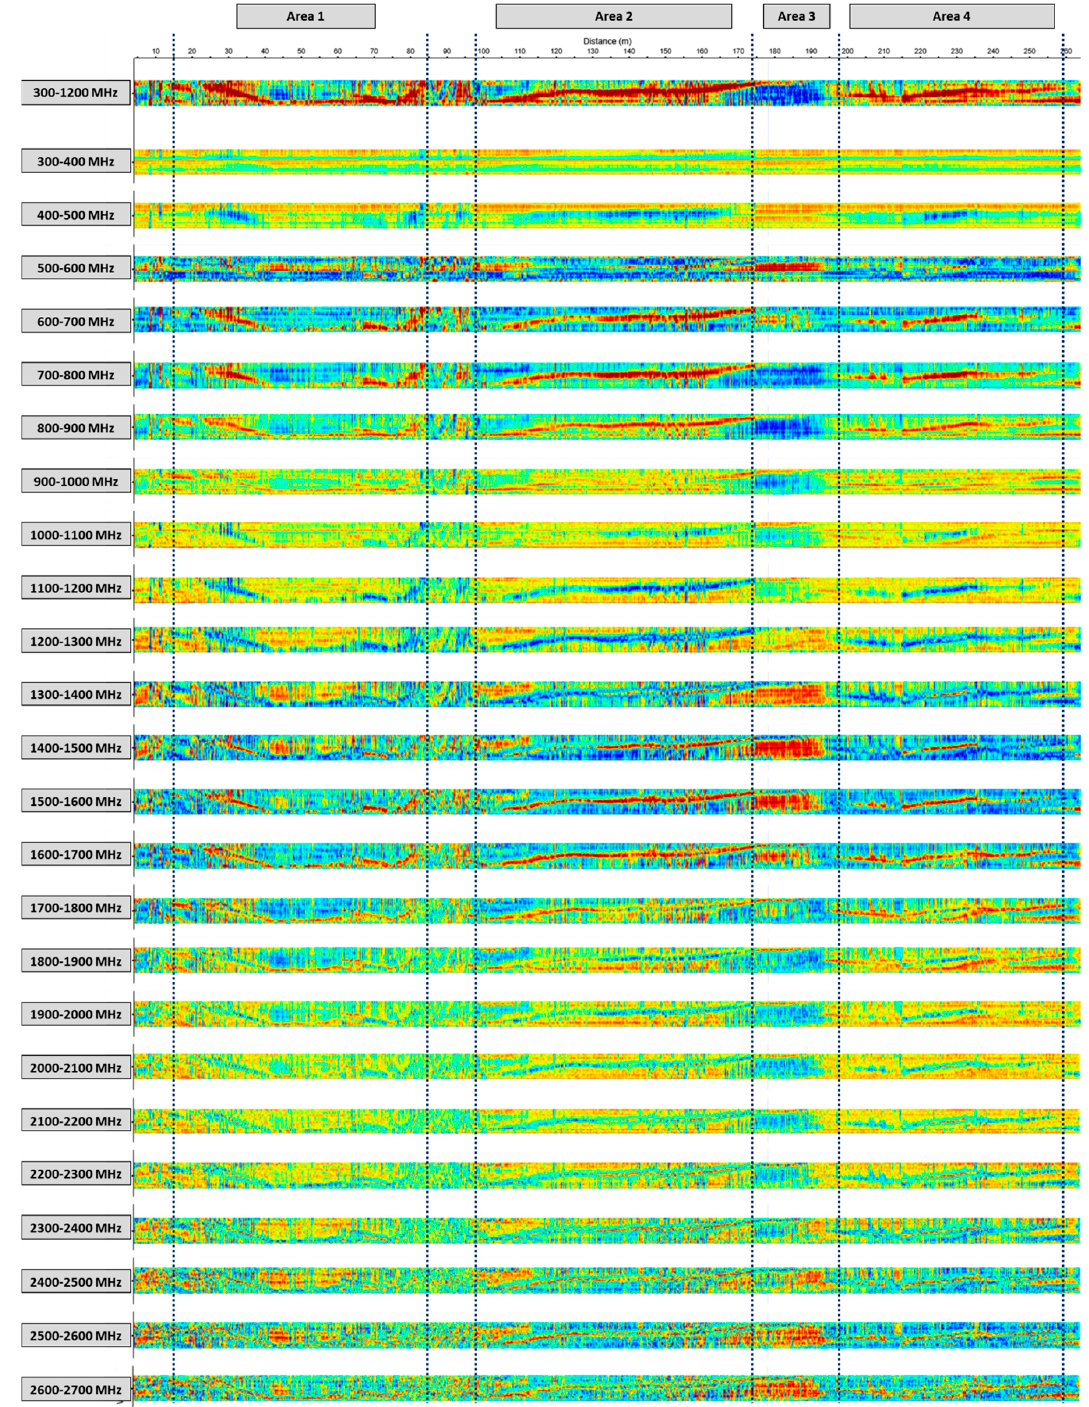
Figure 7. GPR time slices depending on the considered frequency interval (indicated on the left). The full bandwidth result is attached on the top.